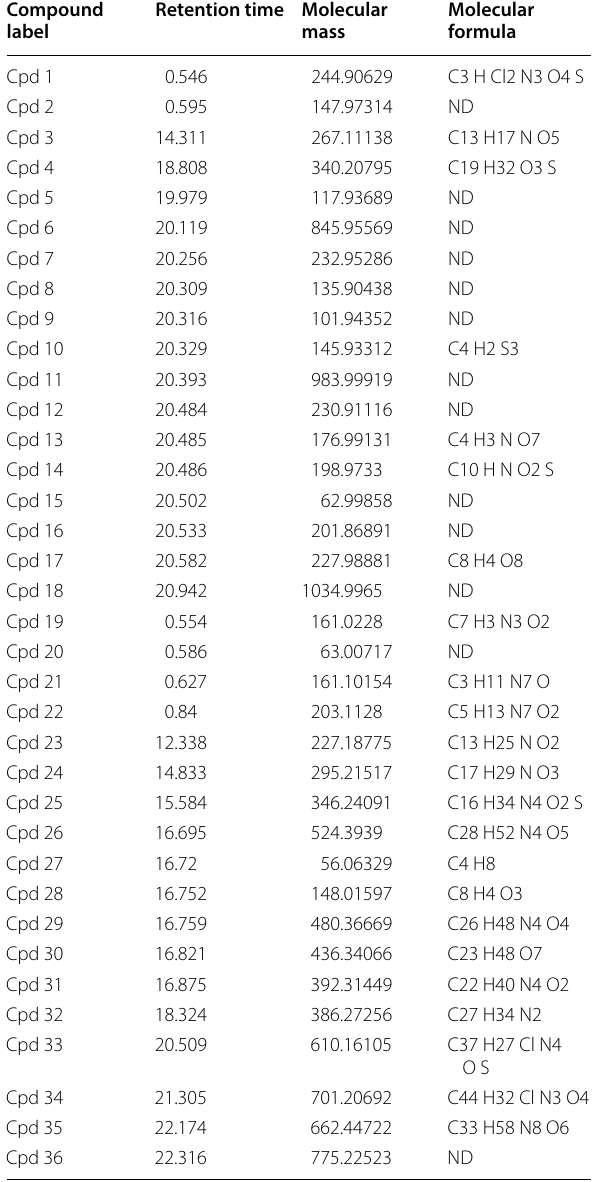
Table 3 Compounds identified in the haemolymph of red- headed